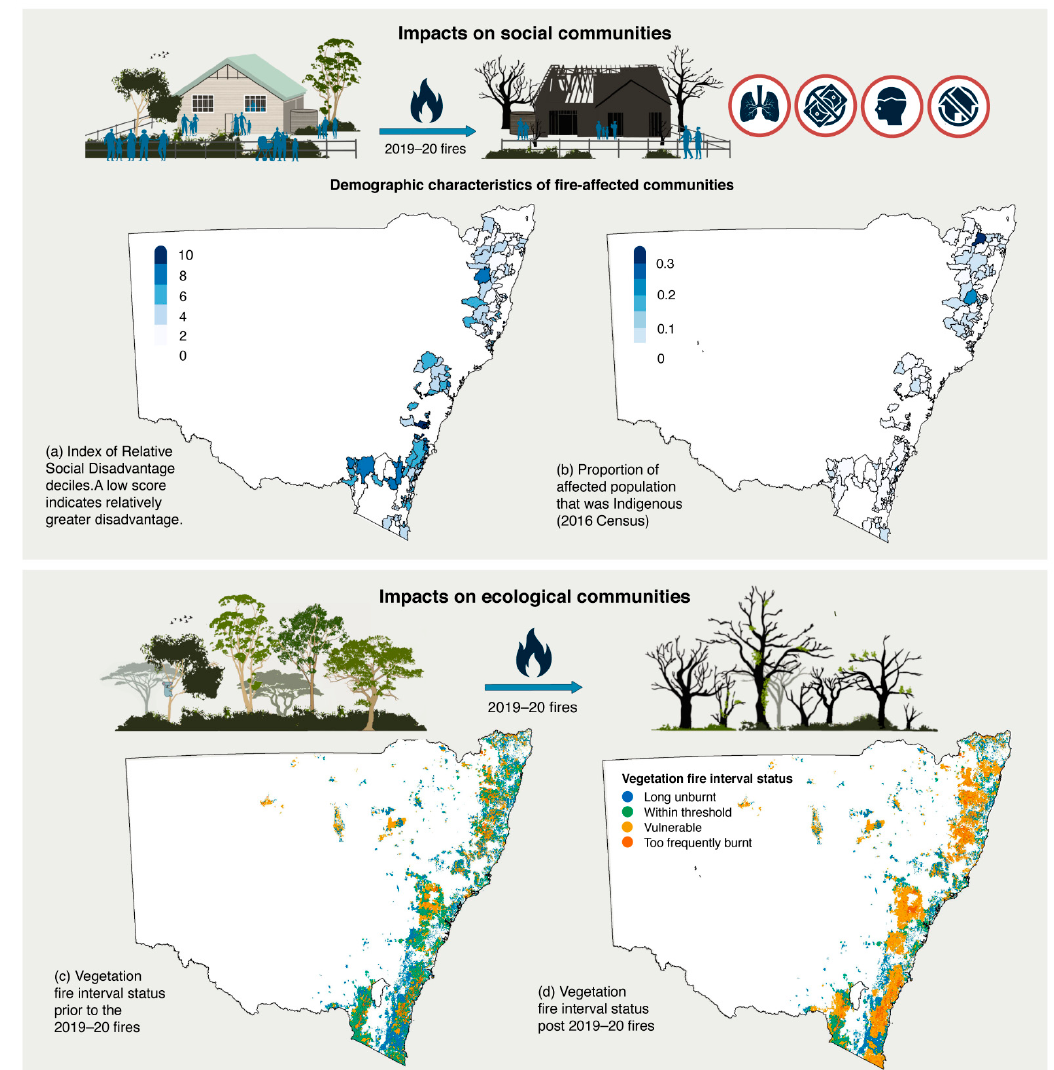
Figure 4. Impacts of the Black Summer fires, illustrating demographic impacts, including ( a ) the Index of Relative Social Disadvantage (IRSD) deciles of affected areas in 2016. The areas represent “Statistical Area Level 1” (SA1), which is the smallest unit possible in the presentation of Australian census data, with an average population size of approximately 400 people [49]. A low score indicates relatively greater disadvantage and high score indicates a relative lack of disadvantage. For further details on the methods see Section 9.5. Our analysis of census data in fire-affected areas revealed the median decile in the Index of Relative Social Disadvantage (IRSD) was 4, indicating a degree of relative social disadvantage. Shown in ( b ) is the proportion of affected SA1 population that was Indigenous at the 2016 census. The average proportion of Indigenous people across Australia in the 2016 census was 0.03 [50]. Additionally illustrated are ecological impacts, with vegetation fire interval status ( c ) prior to and ( d ) following the 2019–20 fire season shown for NSW. Fire-interval status was determined from fire history data and established ecological thresholds for the optimal return-time of fire. These thresholds identify a minimum and maximum number of years between fires in order to maintain the ecological state of the community.